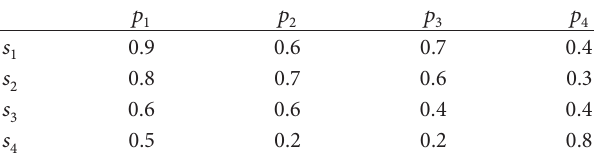
Table 1: Quality of service parameters for a cloud service.